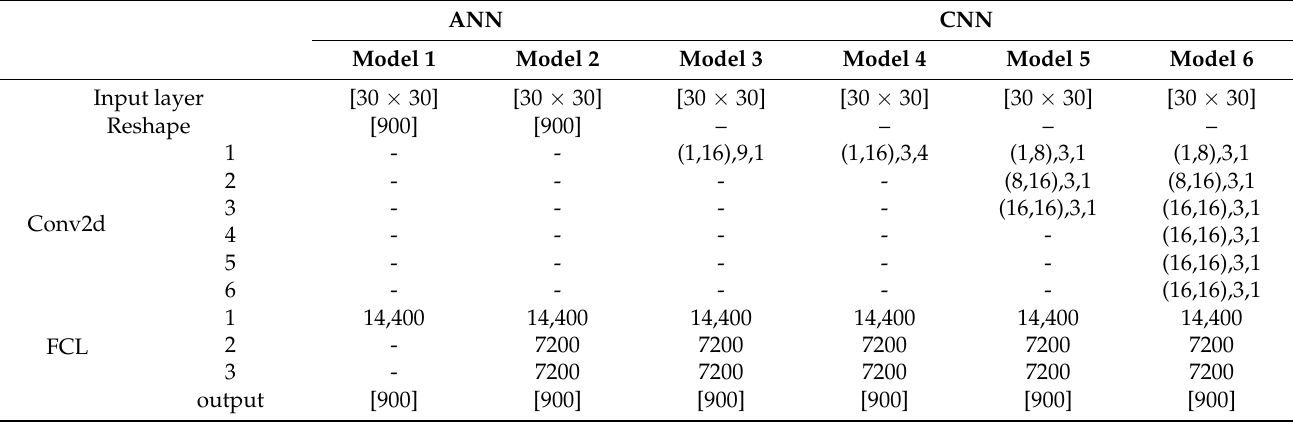
Table 4. Architecture of models in Group A.